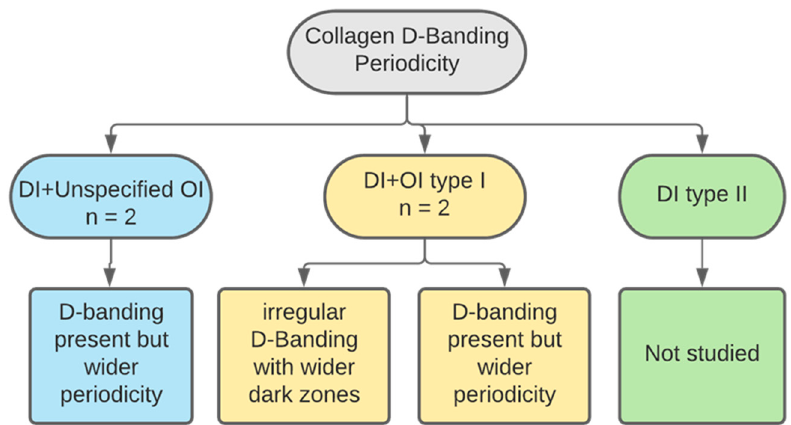
Figure 13. Categorisation of studies reporting on collagen D-banding by DI and OI types.